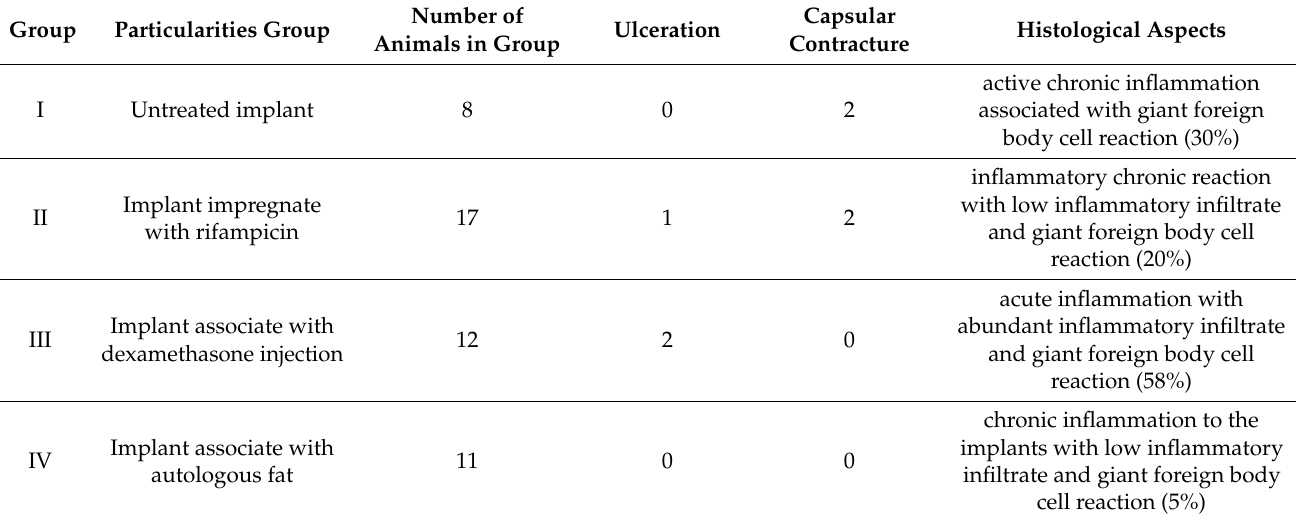
Figure 8. Reduced PMN level at six weeks after surgery. Table 1. Complications and histological results of the studied groups.